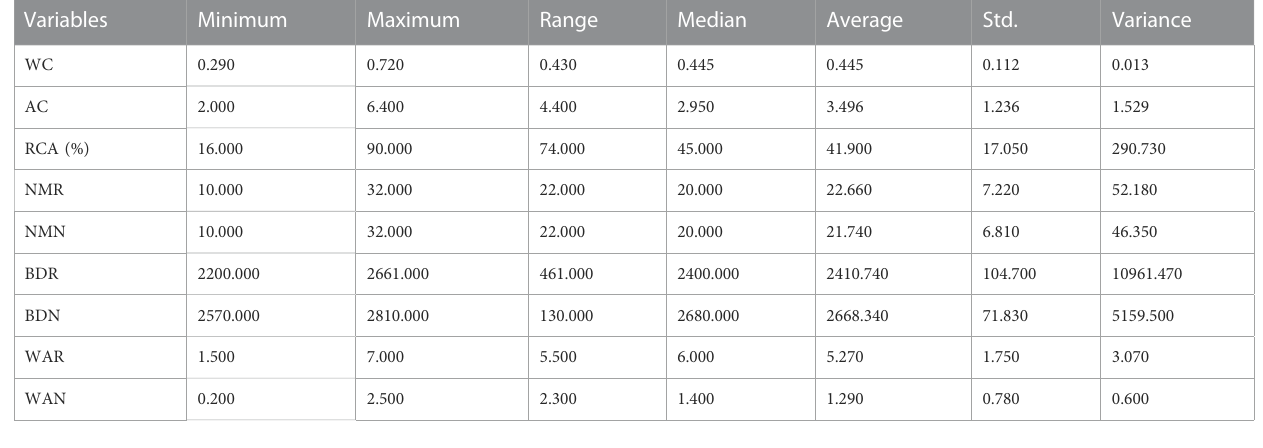
TABLE 1 Statistical analysis of input variables data.